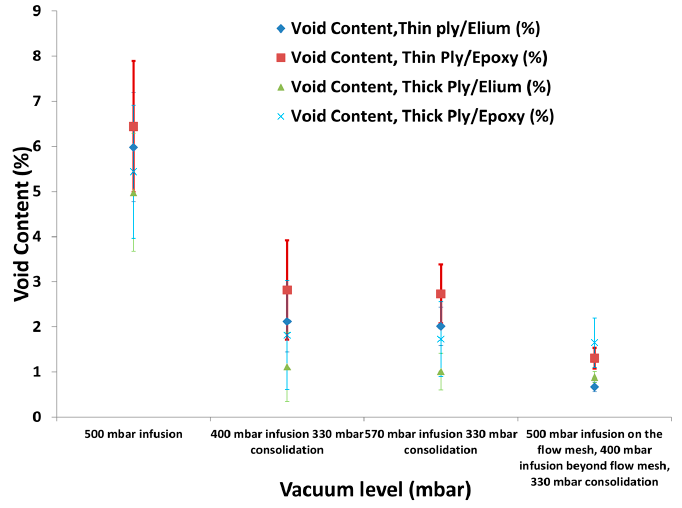
Figure 10. Void contents at one-stage, two-stage and three-stage vacuum level for thick and thin C-Ply™ with TP and TS matrices. C-Ply™ with TP and TS